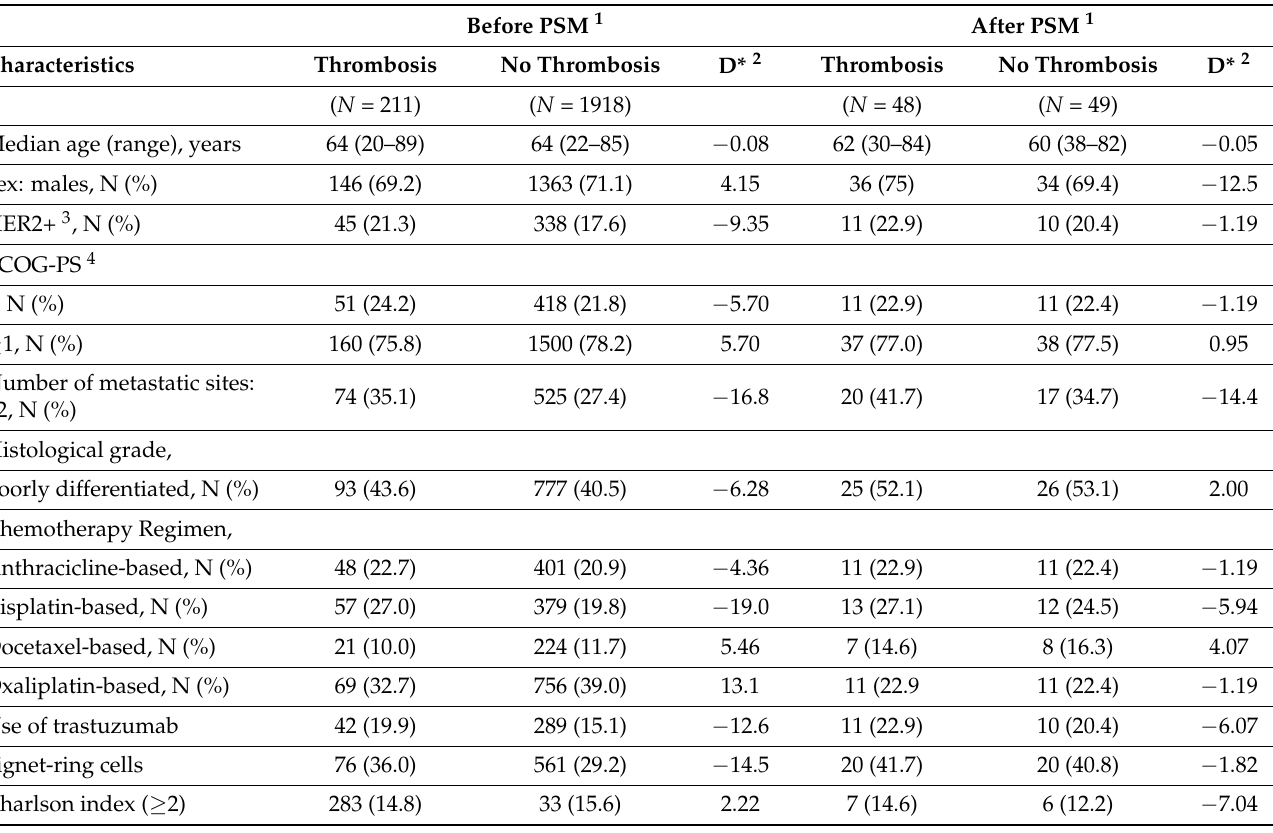
Table 1. Baseline characteristics of patients with and without thrombosis. We show said characteristics in the cohort from AGAMENON registry before applying Propensity Score Matching, and in our selected cohort after applying such matching. Standardized differences or D* were applied to assess the balance